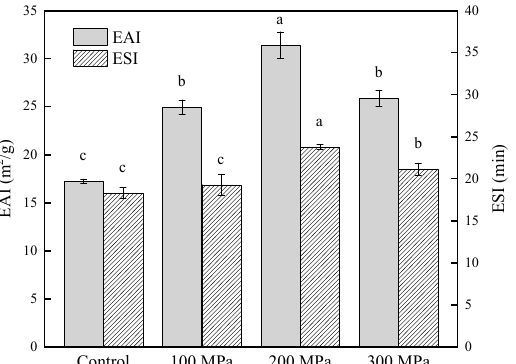
Figure 2. Effect of HHP pretreatment on the EAI and ESI of RBPH. HHP: high hydrostatic pressure; RBPH: rice bran protein hydrolysates; EAI: emulsifying activity index; ESI: emulsifying stability index. Control, 100 MPa, 200 MPa, and 300 MPa represent RBPH samples subjected to 0, 100, 200, and 300 MPa pretreatment, respectively. Different lowercase letters indicate values that differ significantly ( p < 0.05). All the HHP pretreatments were conducted at 25 °C for 30 min.